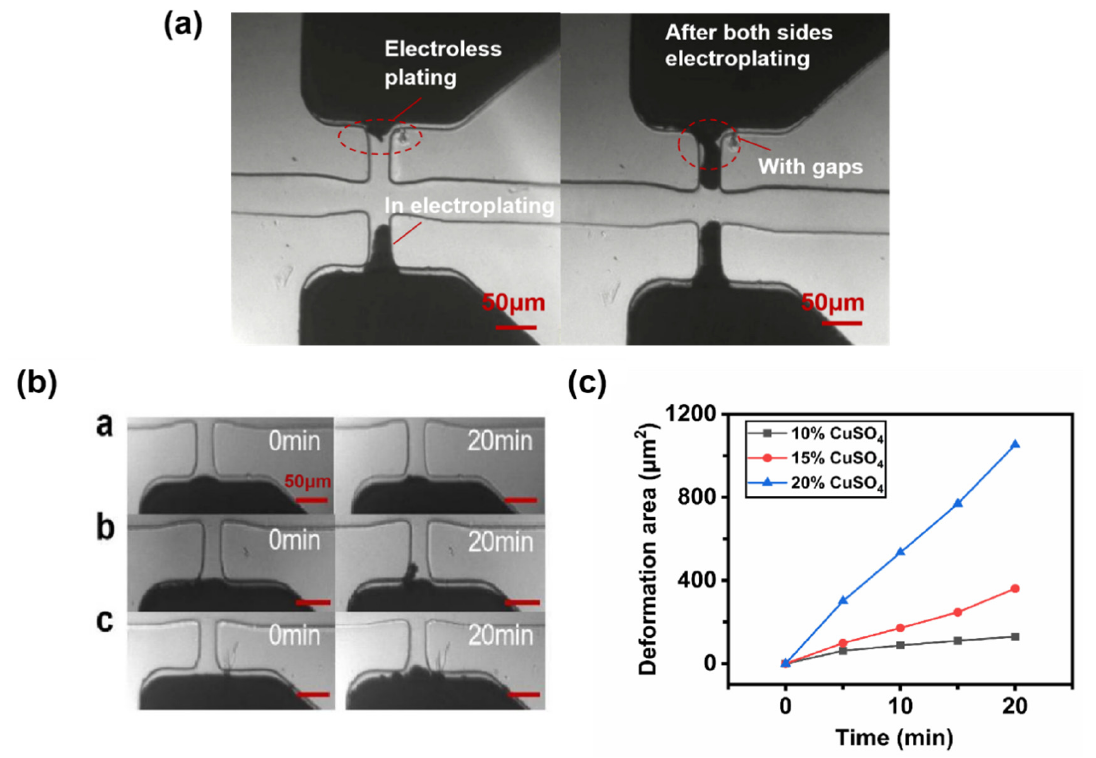
Figure 3. Effect of electroless plating: ( a ) Effect of electroless plating on the microelectroplating process by CuSO 4 with high concentration. ( b ) Electroless plating conditions of microelectrodes over 20 min at different CuSO 4 concentrations: a . 10% CuSO 4 ; b . 15% CuSO 4 ; c . 20% CuSO 4 . ( c ) Electroless plating areas at different CuSO 4 concentrations.